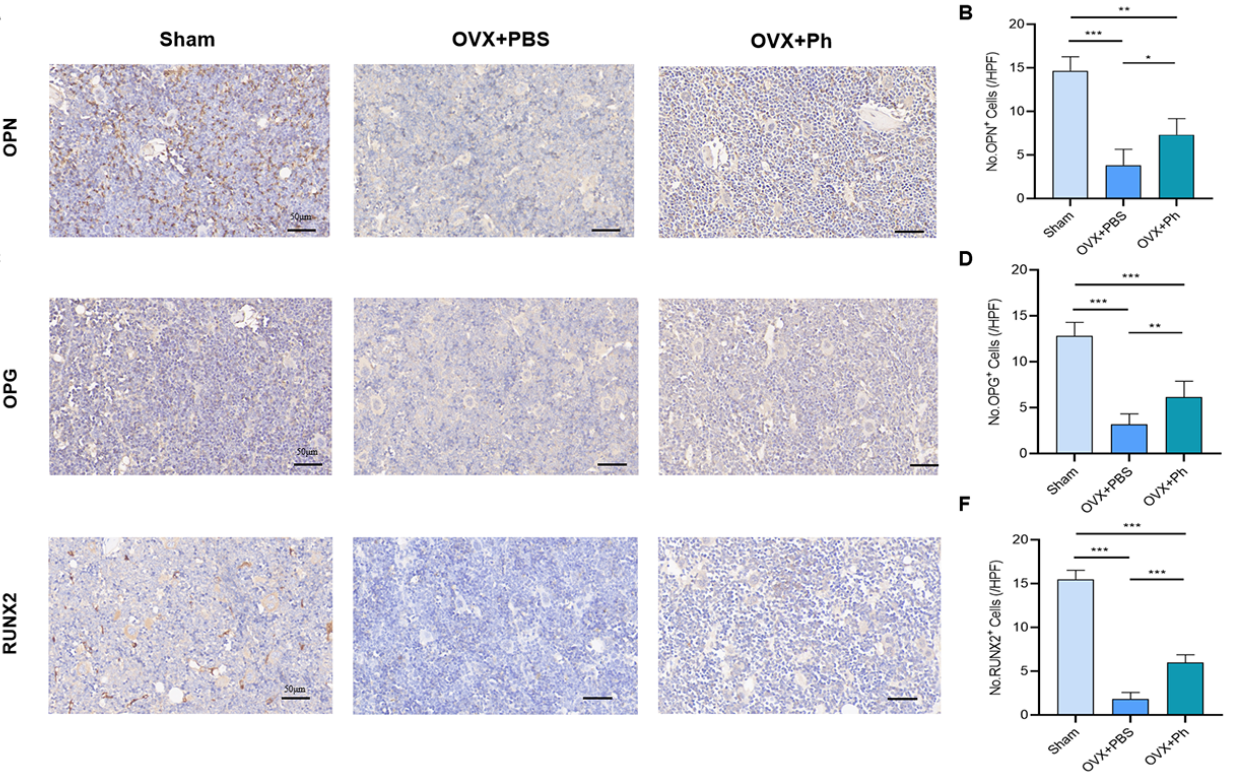
Figure 4. The perfusion of Ph facilitated the osteogenesis. ( A ) OPN stained the sections of distal femur tissues. The scale bars represented as 50 µ m; ( B ) No. OPN + cells; ( C ) The OPG stained the sections of distal femur tissues. The scale bars represented as 50 µ m; ( D ) No. OPG + cells; ( E ) The RUNX2 stained the sections of distal femur tissues. The scale bars represented as 50 µ m; ( F ) No. RUNX2 + cells. * p < 0.05, ** p < 0.01, and *** p < 0.001 compared with comparable group.